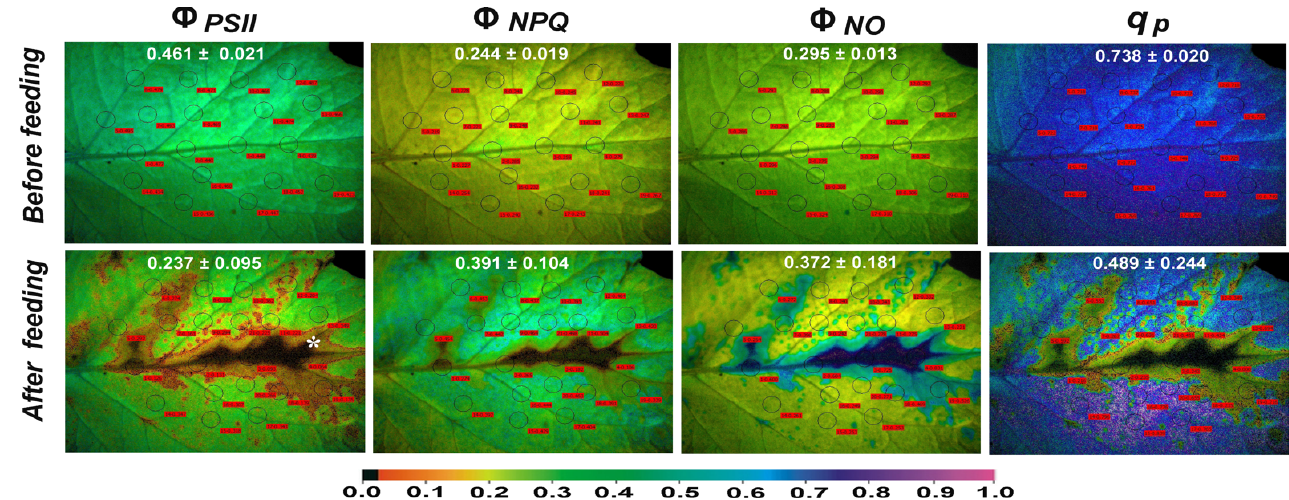
Figure 5. Typical colour-coded images of Φ PS ΙΙ , Φ NPQ , Φ NO , and q p , of a potato leaflet before insect feeding ( upper row ) and immediately after 90 min feeding ( second row ) by Halyomorpha halys . The areas of interest (AOIs) that were measured are shown in circles with values in red labels. The whole leaflet values (average ± SD) are given with the white numbers. In the image of Φ PS ΙΙ after 90 min feeding; asterisk indicates Φ PSII value 0.064. The colour code at the bottom ranges from pixel values 0.0 to 1.0.